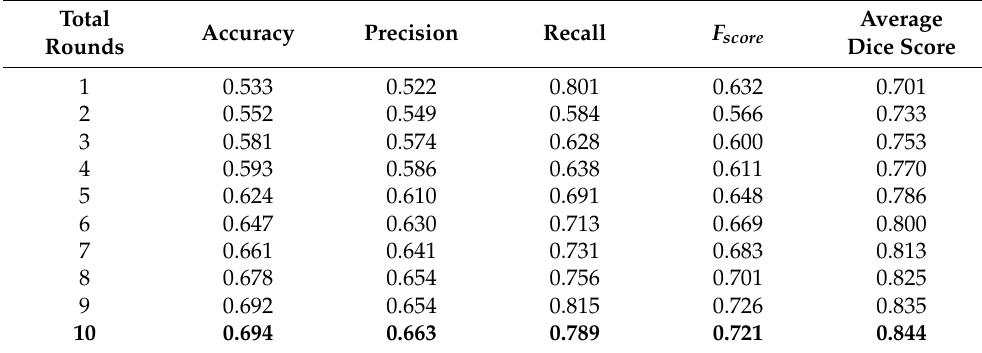
Table 8. Round-wise test results obtained from Raspberry Pi-centric federated semi-supervised learning-based training. The best performance is highlighted in bold.